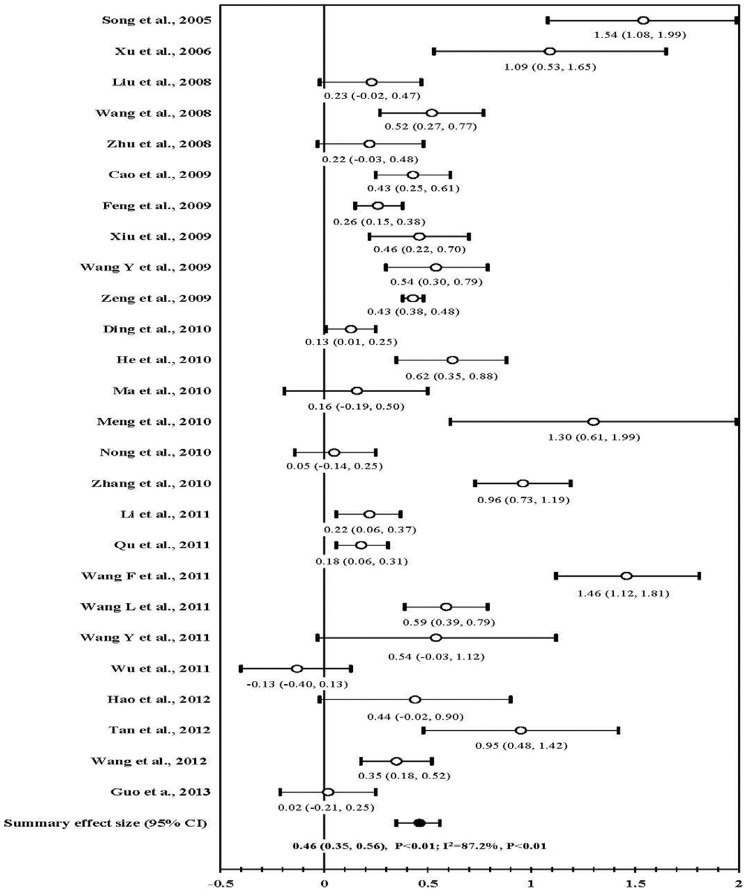
Forest plot of effect size: the impact of behavioral interventions on consistent condom use during anal intercourses with any male sexual partners among MSM in China.